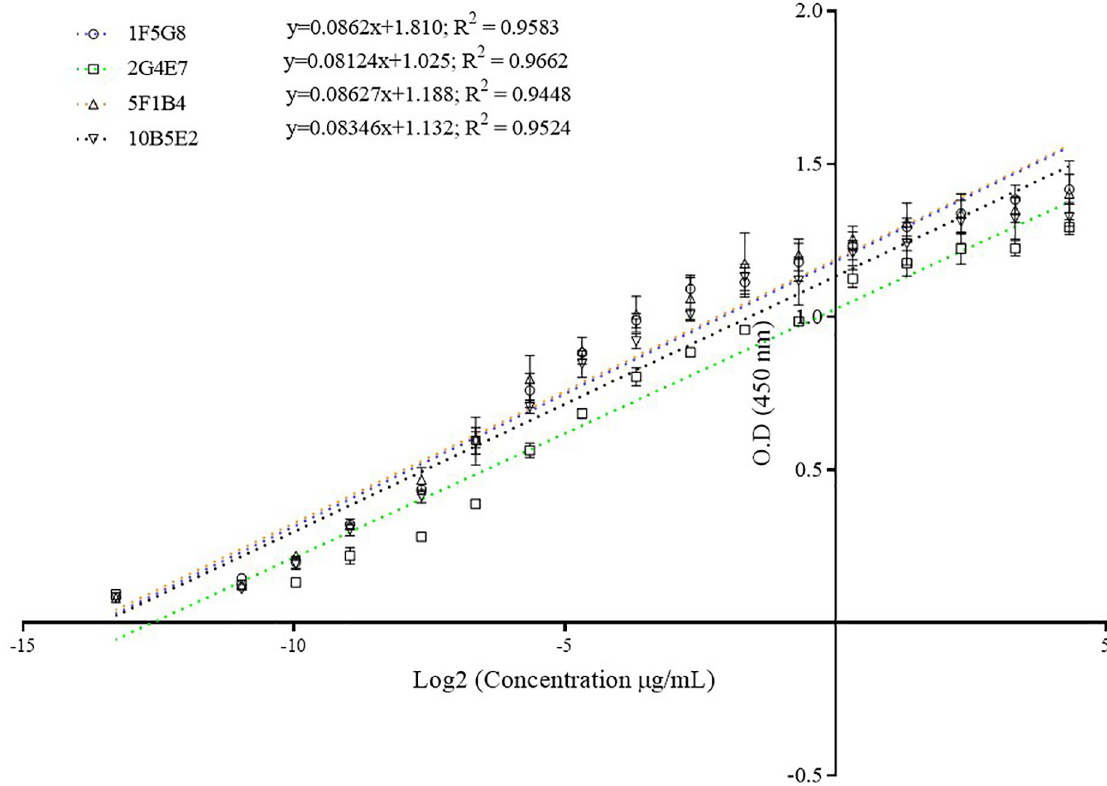
Fig 6. Calibration curves for each monoclonal antibody in a sandwich ELISA assay. The graphic shows the linear curves between OD and Log2 (ILTV gG recombinant protein concentration [ μ g/mL]). The equations and correlation coefficient (R 2 ) are shown for each evaluated monoclonal